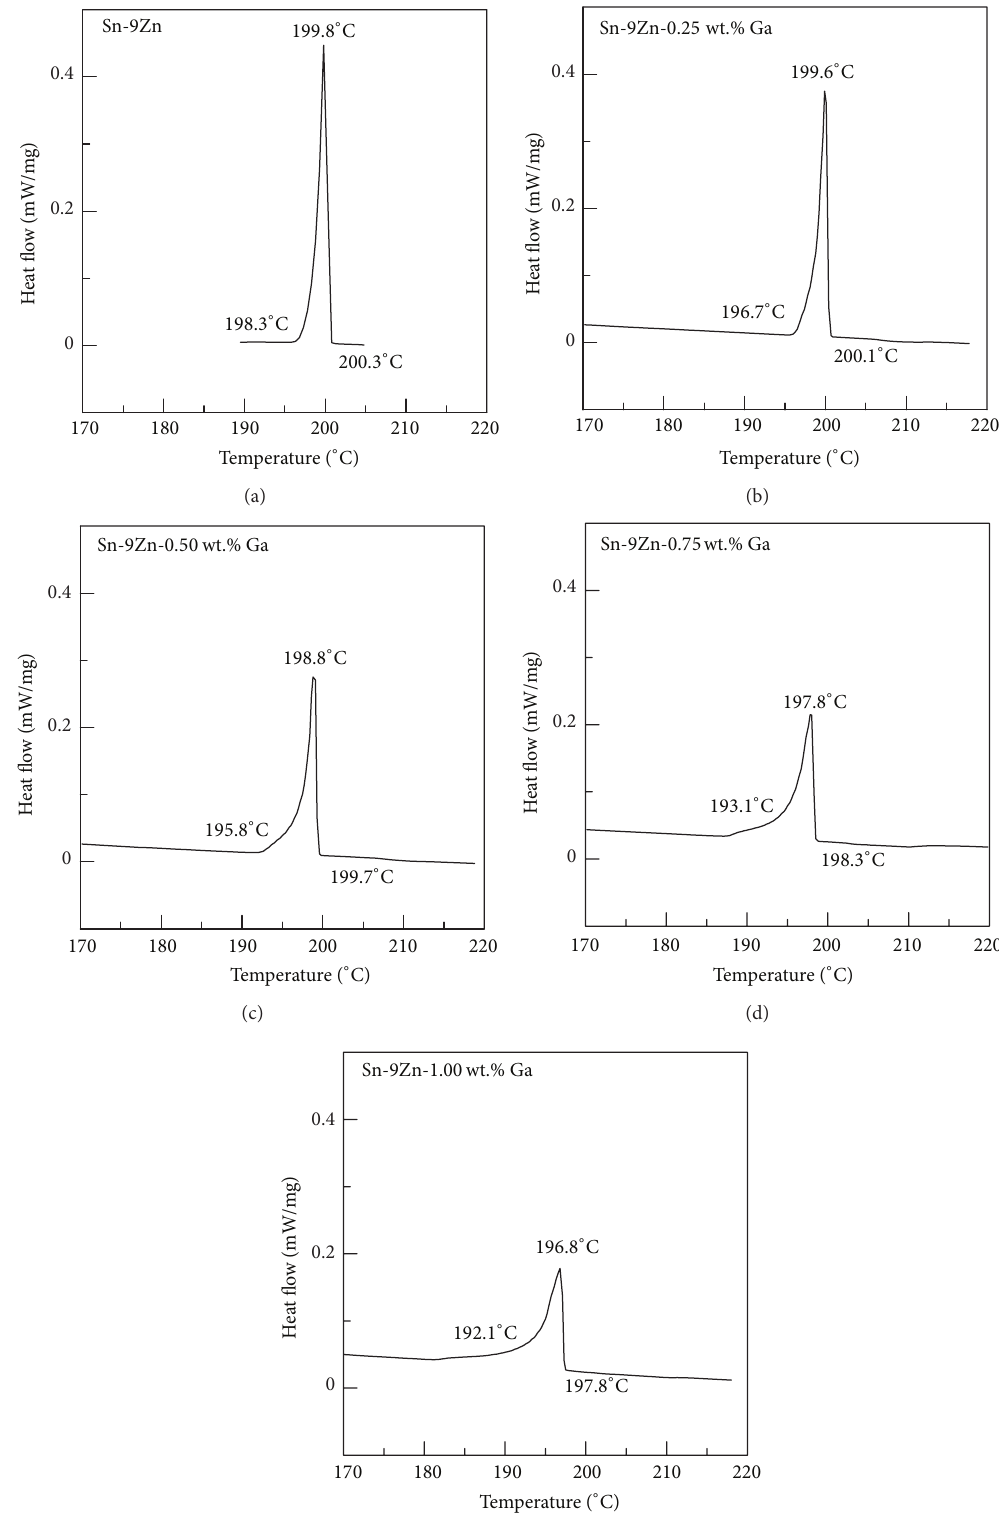
Figure 1: The DSC curves of the Sn-9Zn- 𝑥 Ga solder alloys containing (a) 0wt.% Ga, (b) 0.25 wt.% Ga, (c) 0.50 wt.% Ga, (d) 0.75 wt.% Ga, and (e) 1.00wt.% Ga upon heating at a scanning rate of 0.5 ∘